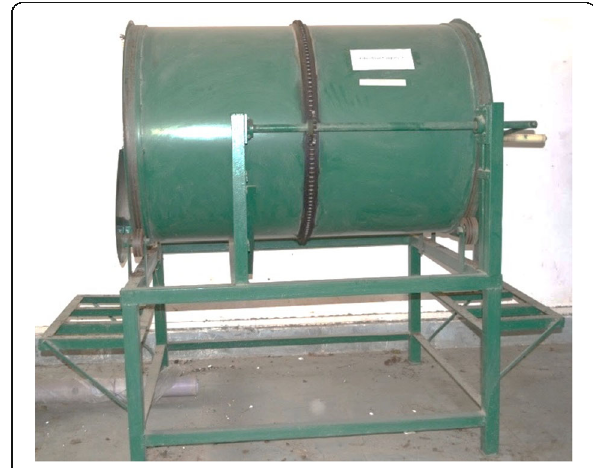
Fig. 1 Photo of rotary drum composter used in this